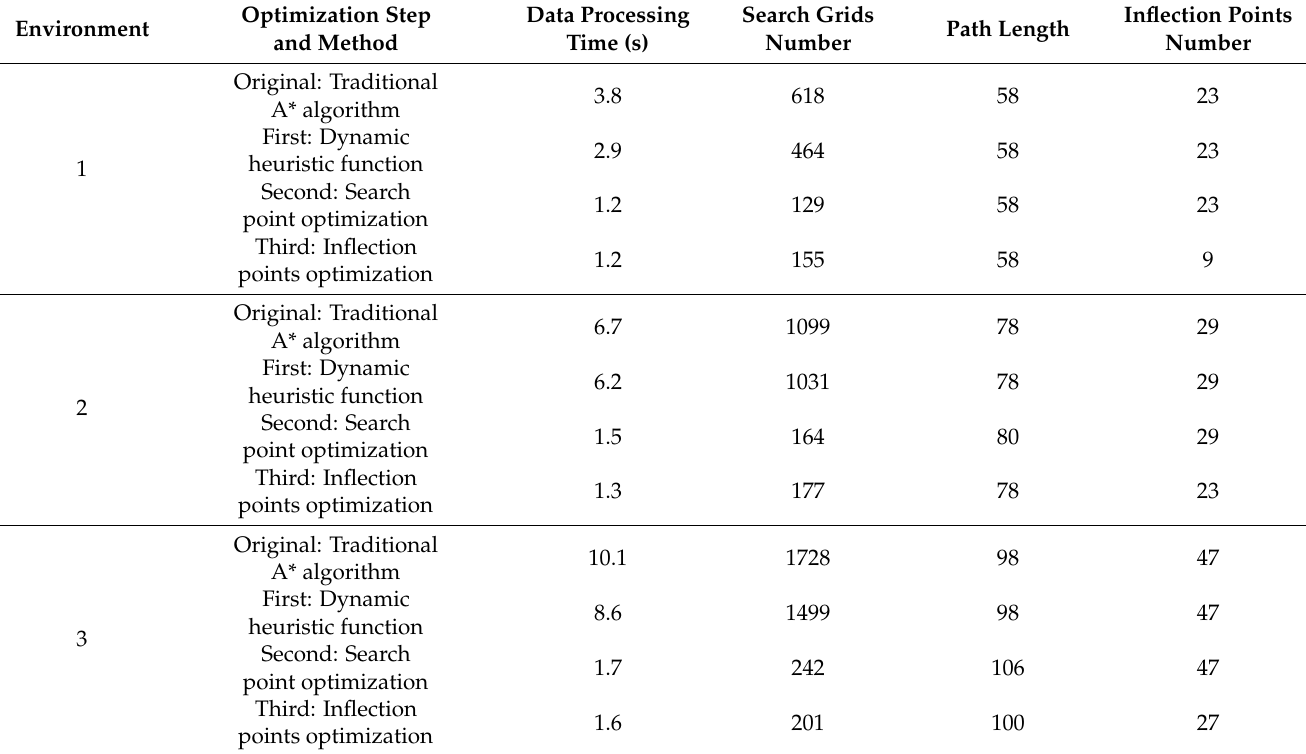
Table 5. Algorithm performance for different environments and optimization steps.